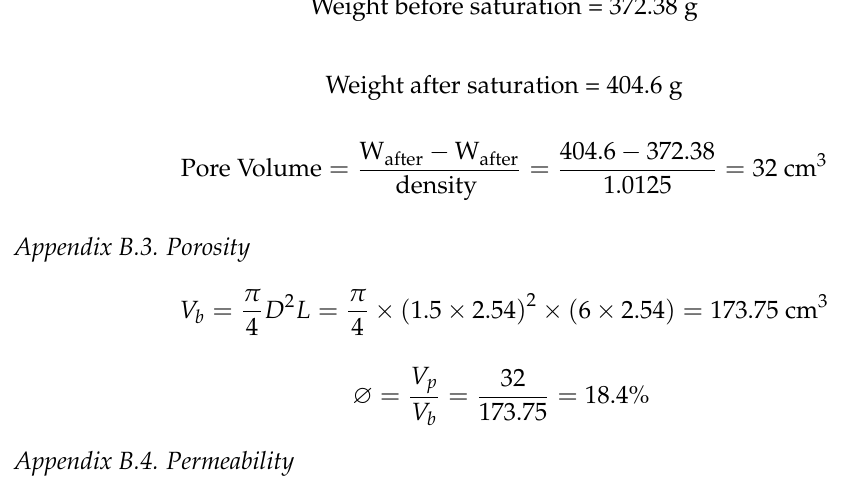
Table A5. Permeability variations with different flow